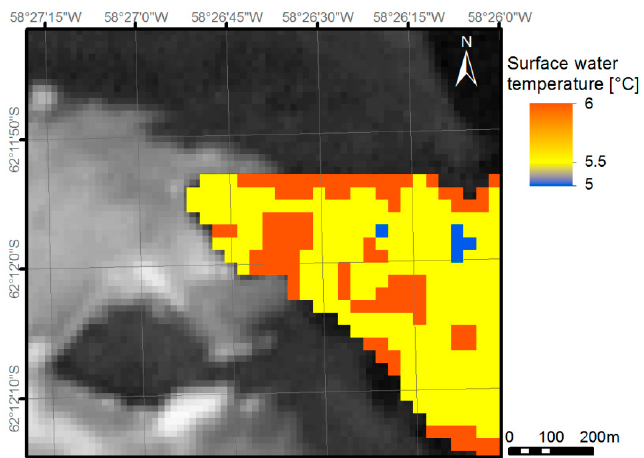
Figure 6. Surface water temperature based on Landsat imagery acquired on 4 February 2003.